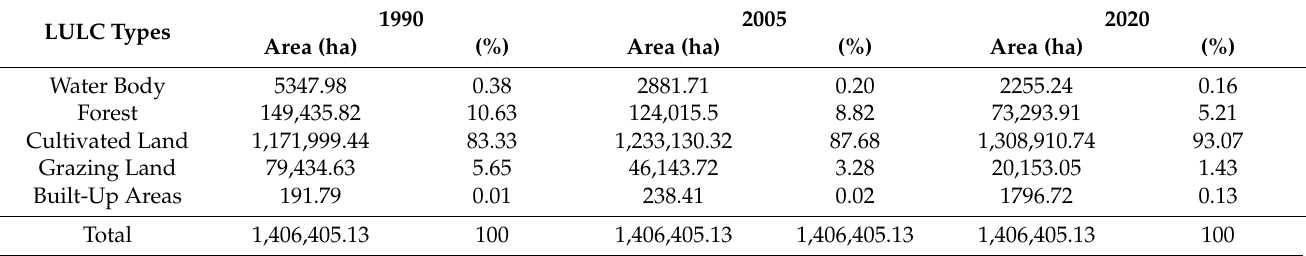
Table 2. The extent of area covered with the five land use types